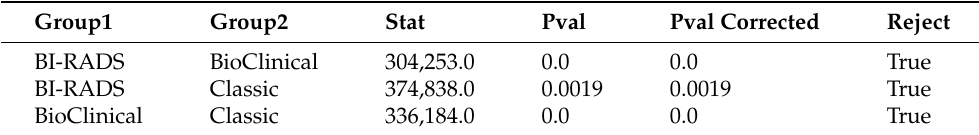
Table A4. Bonferonni-corrected Mann–Whitney U test results for section segmentation without auxiliary data in an ablation study with 10% of training data.